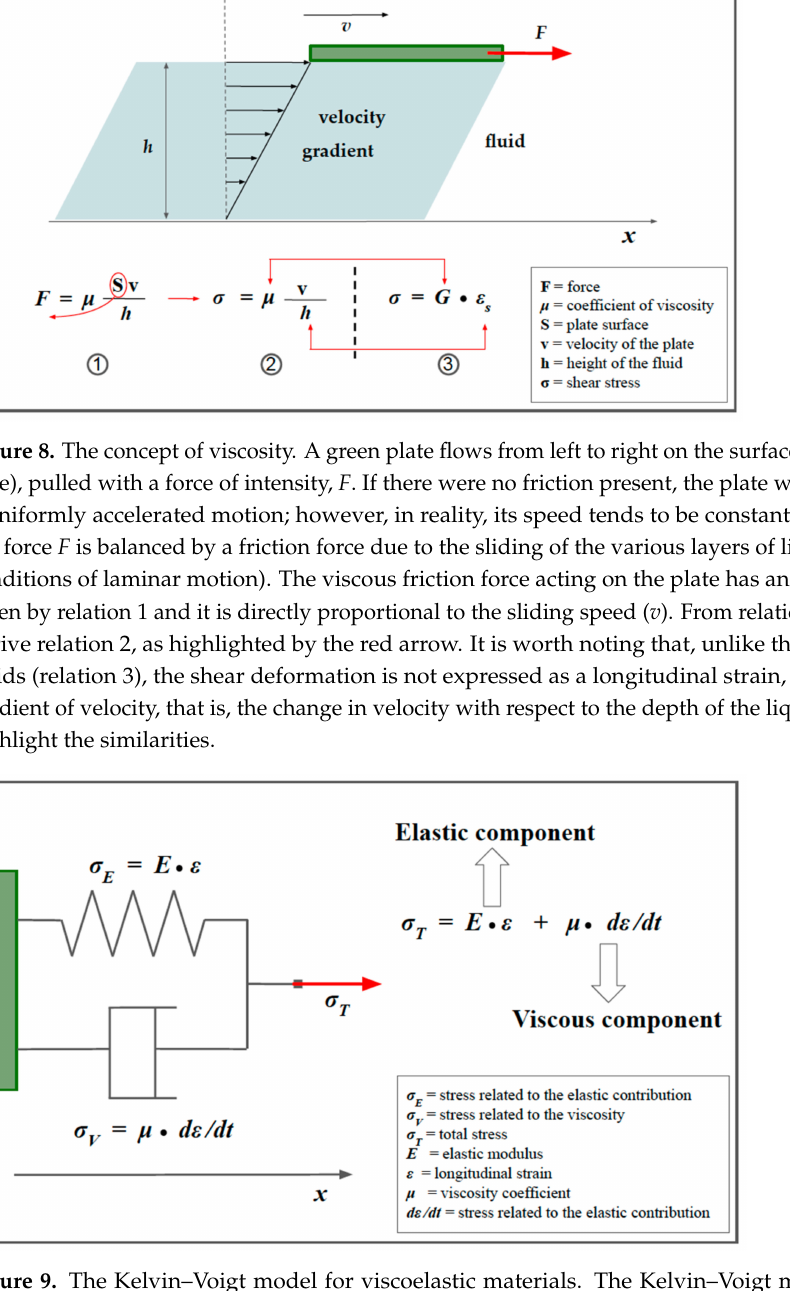
Figure 9. The Kelvin–Voigt model for viscoelastic materials. The Kelvin–Voigt model is used to describe viscoelastic materials. This model is represented by a purely viscous damper ( bottom ), connected in parallel to a purely elastic spring ( top ). The constitutive equation associated with the model is represented on the right. For more explanations, see the main